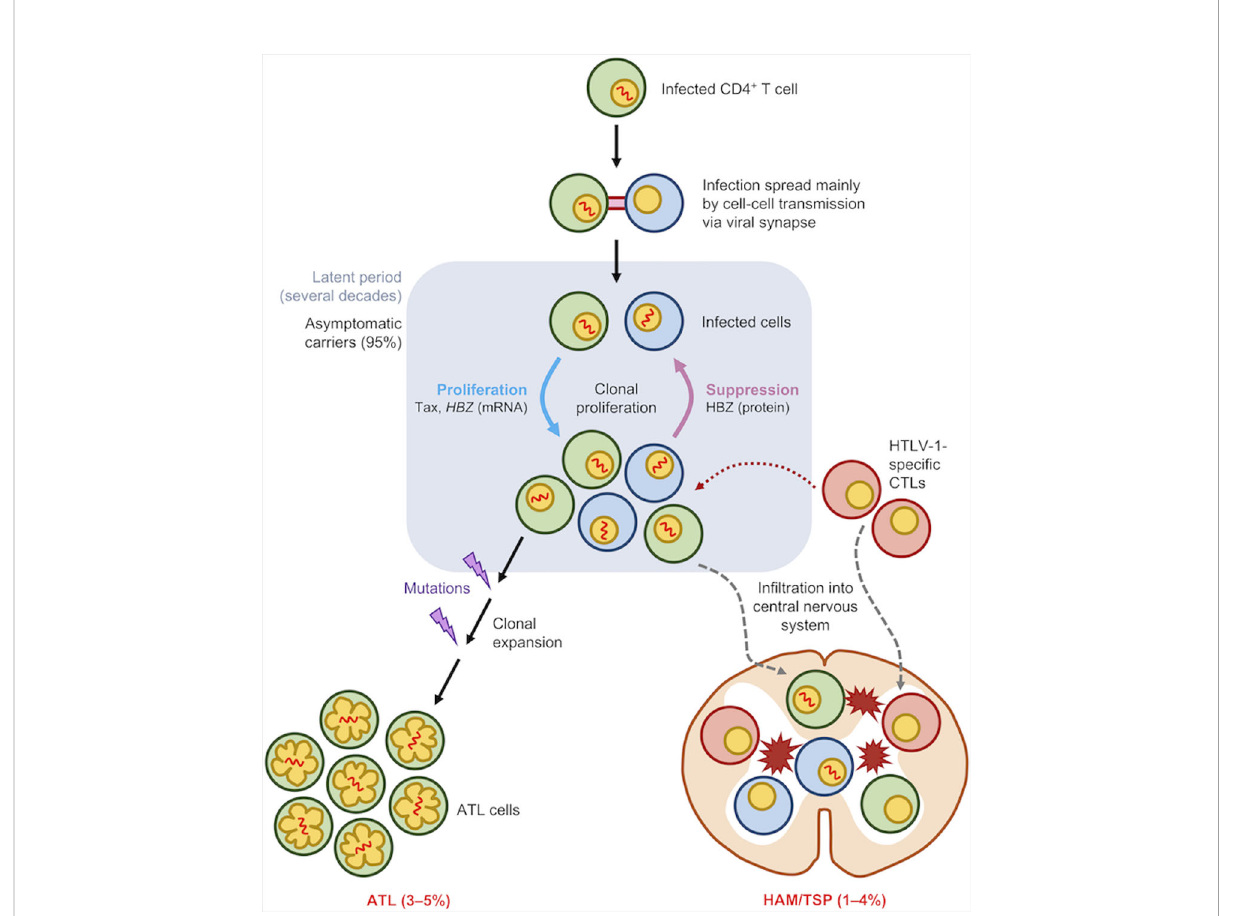
FIGURE 1 Natural history of HTLV-1 infection. HTLV-1 primarily infects CD4+ T cells and spread mainly by cell-to-cell transmission via viral synapse. The pool of infected cells are maintained by clonal proliferation which is promoted by Tax, HBZ mRNA and other viral accessory proteins while HBZ protein and host CTLs act to suppress them. Most HTLV-1-infected individuals remain life-long asymptomatic carriers. However, in approximately 5% of infected individuals, acquisition and accumulation of certain mutations leads to malignant transformation of infected cells into adult T-cell leukemia (ATL) cells. Additionally, about 4% of infected individuals develop HTLV-1-associated myelopathy/tropical spastic paraparesis (HAM/TSP), which is caused by in fi ltration of infected cells and CTLs into the central nervous